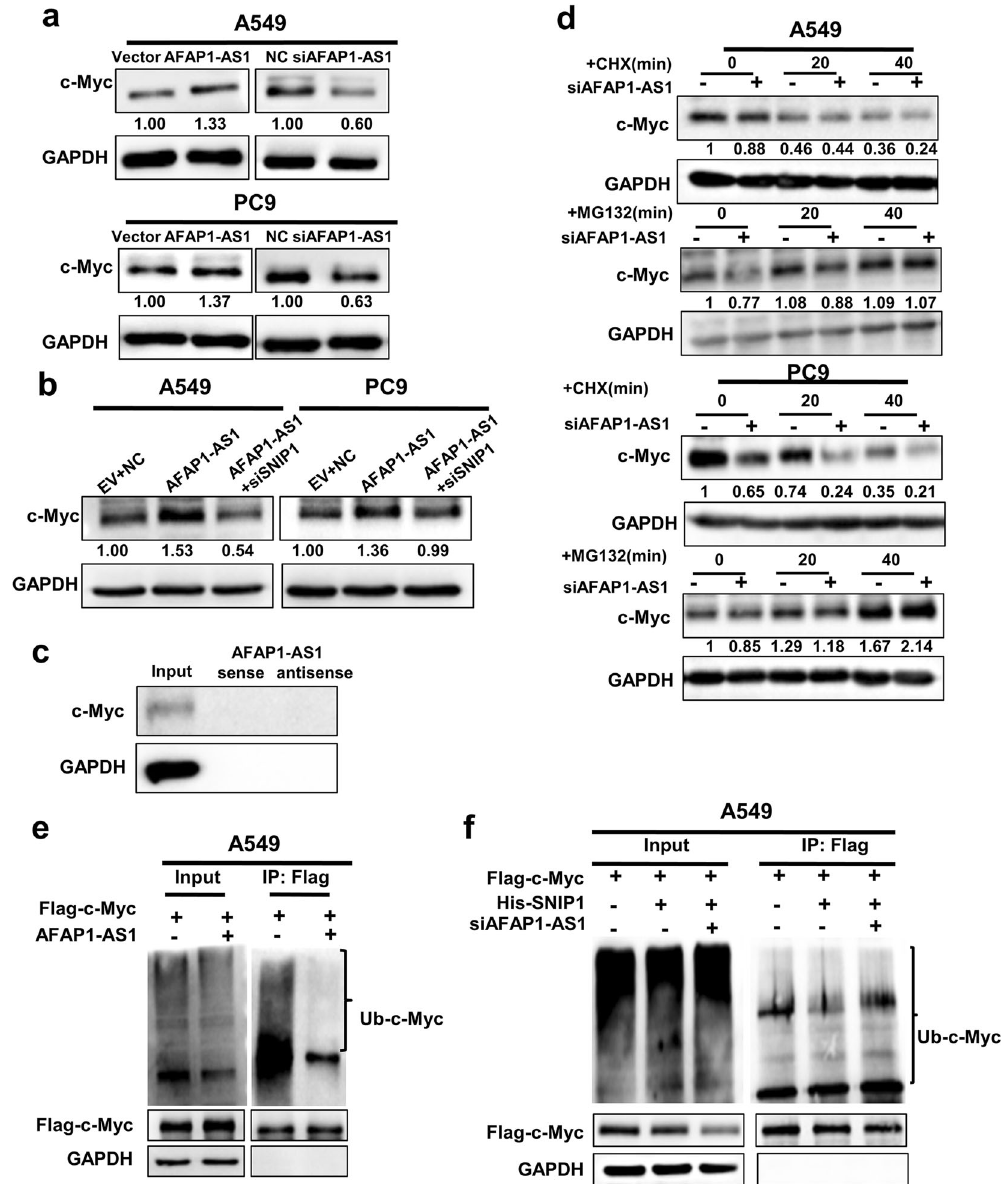
Fig. 6 AFAP1-AS1 upregulates c-Myc protein level and inhibits c-Myc ubiquitination through binding to SNIP1. a The c-Myc expression was detected in A549 and PC9 cells after knockdown or overexpression of AFAP1-AS1 by western blotting. b Knockdown of SNIP1 attenuated the regulation of AFAP1-AS1-mediated upregulation of c-Myc protein. c No binding between AFAP1-AS1 and c-Myc showed by RNA pull down assay. d c-Myc expression was assessed in A549 and PC9 cells treated with 50 μ g/ml CHX or 20 μ M MG132 for 0 – 40 min after AFAP1-AS1 knockdown. The results showed that only MG132 abolished the AFAP1-AS1 knocked down-mediated downregulation of c-Myc. e The c-Myc ubiquitination was dramatically decreased in A549 cells after overexpression of AFAP1-AS1 using IP experiment. f The ubiquitination of c-Myc protein was abolished in A549 cells after co-transfection with His-SNIP1, the Flag-c-Myc vector and the pool of two siRNAs targeting AFAP1-AS1 using IP